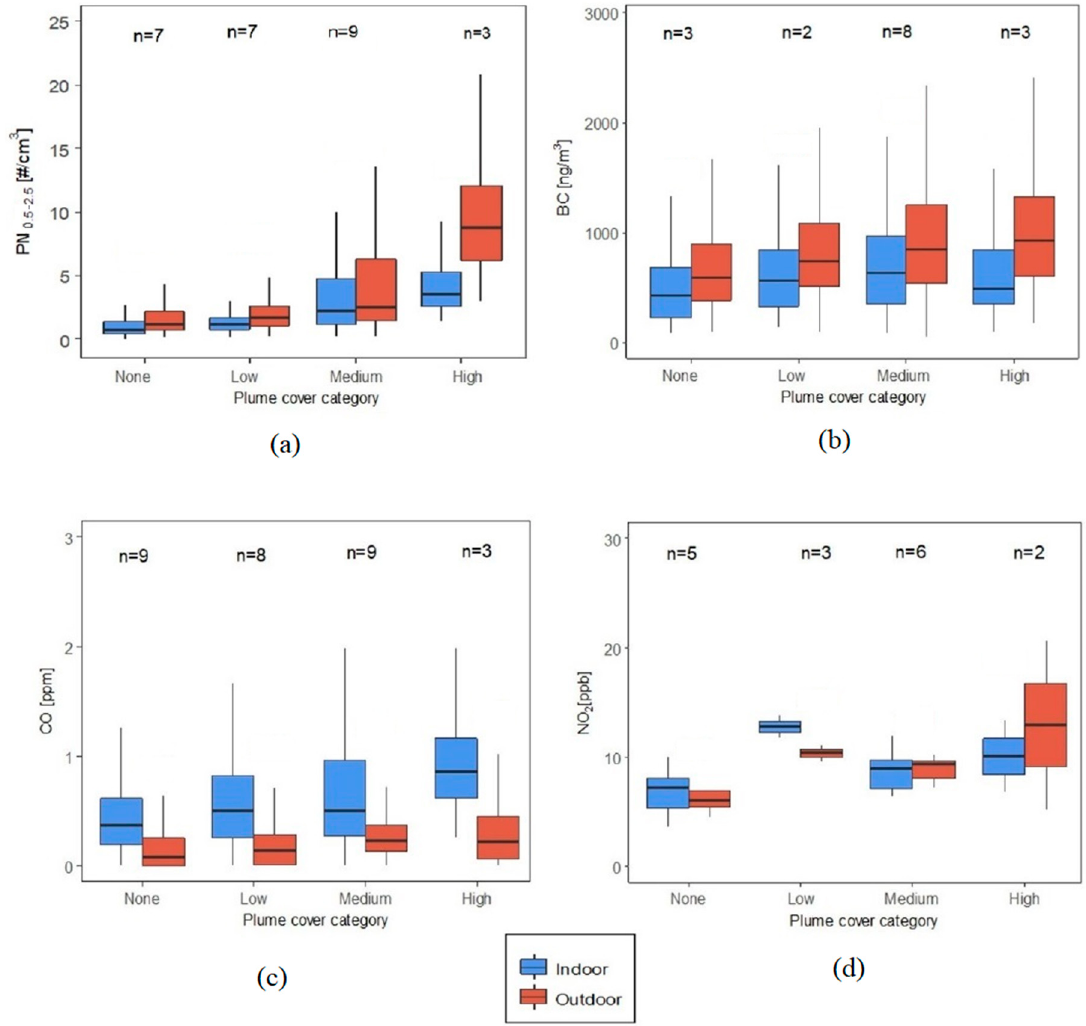
Figure 10. Indoor and outdoor pollutant concentration distributions (not showing outliers) according to wildfire plume cover (filtered datasets) for ( a ) PN 0.5-2.5 , ( b ) BC, ( c ) CO and ( d ) NO 2 . The indoor and outdoor concentrations between all plume categories were significantly different for all pollutants except NO 2 (K-W test at α = 0.05).